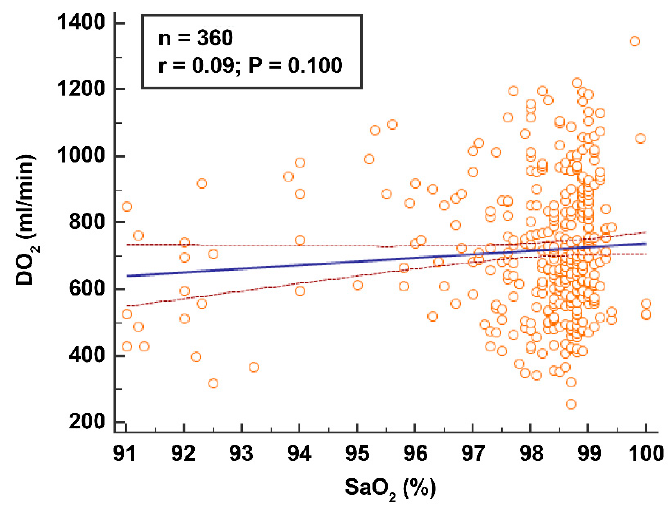
Figure 3. DO 2 was not correlated with SaO 2 (r = 0.09, p = 0.100). Lines are a regression line with